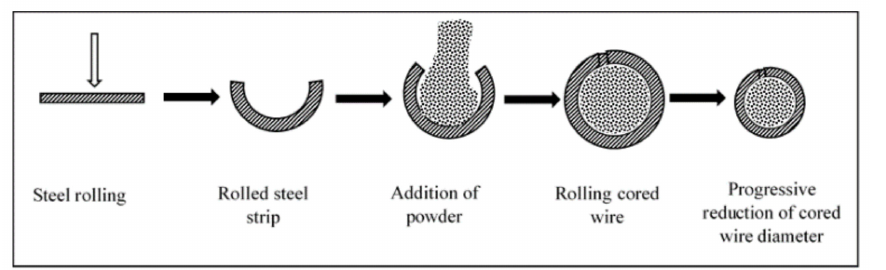
Figure 2. Schematic diagram of cored wire preparation. Reprinted with permission from ref. [44]. Copyright 2007